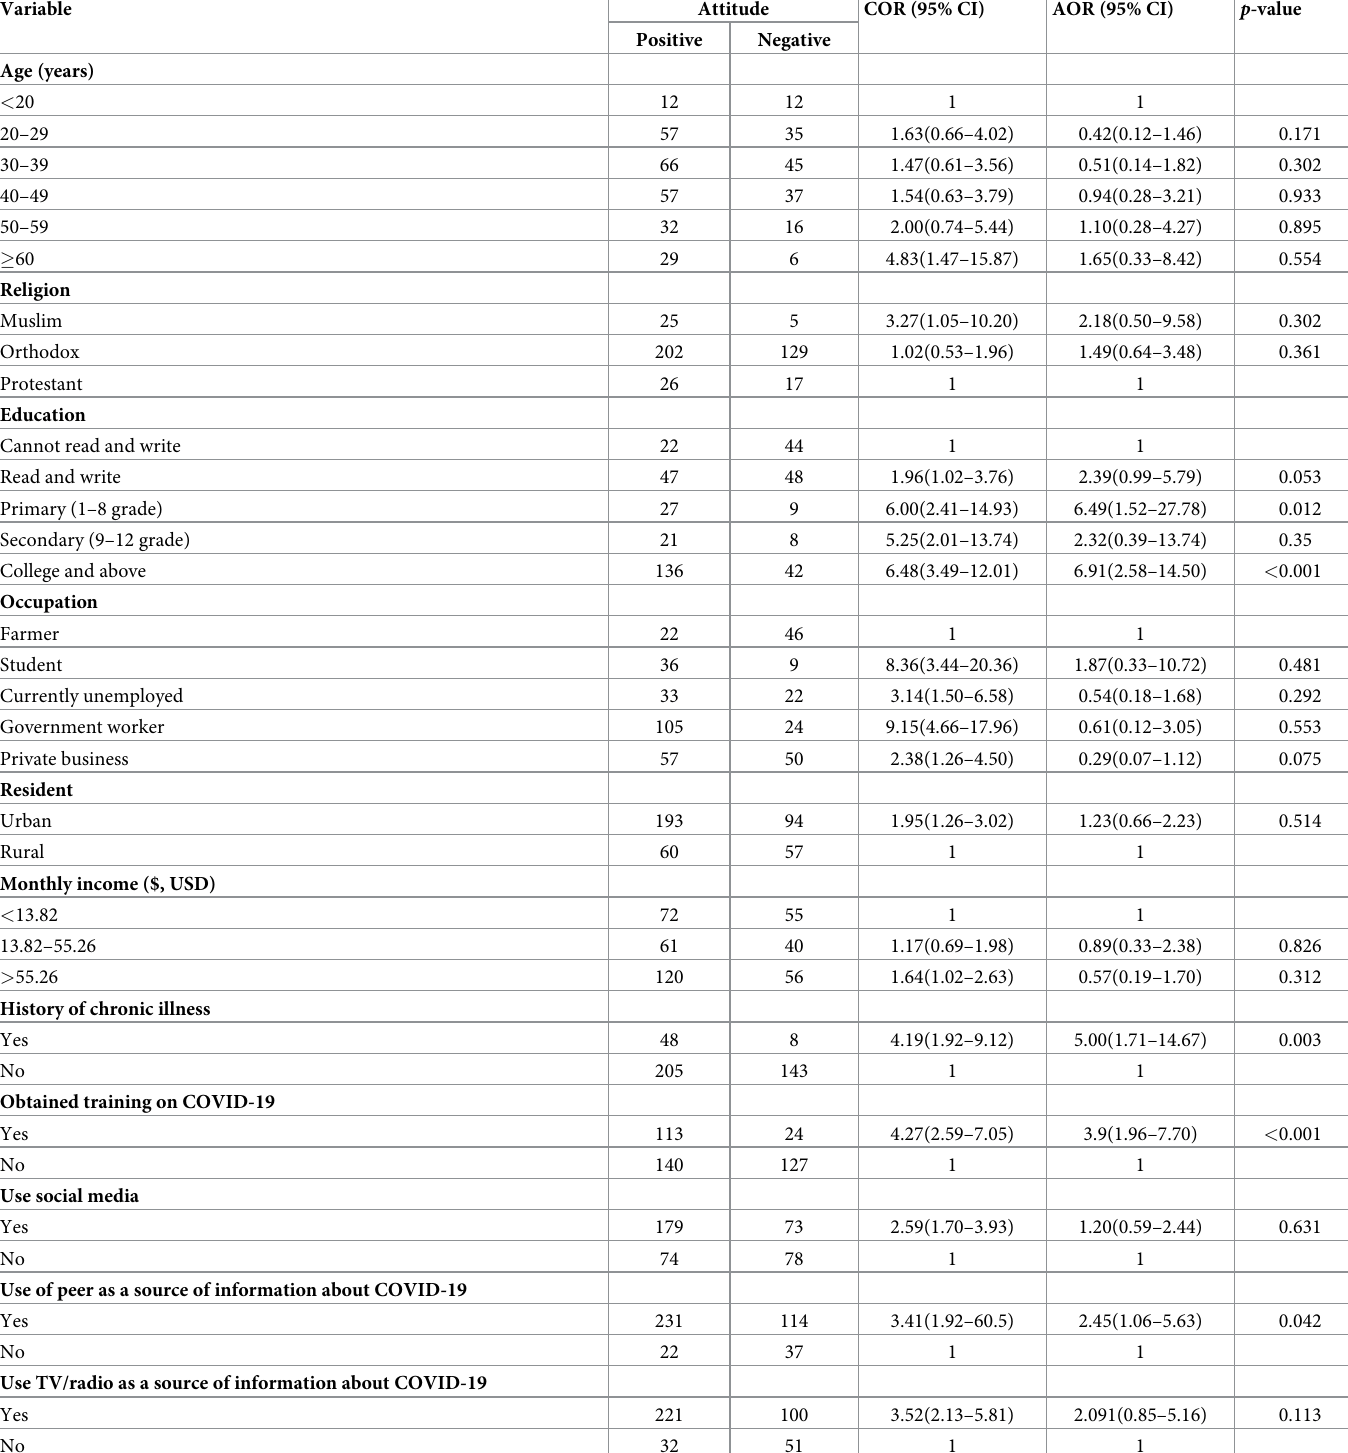
Table 6. Factors associated with attitude towards COVID-19 prevention among adult visitors in hospitals of South Gondar zone, Northwest Ethiopia, in August 1 to 30,